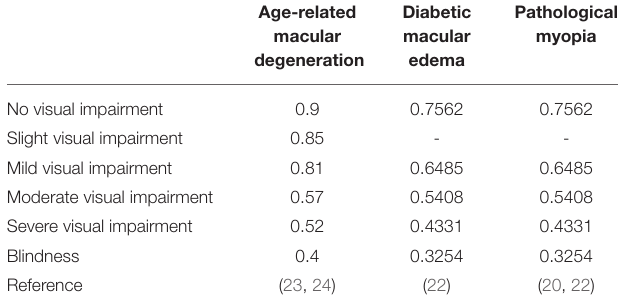
TABLE 3 | Health utility value.